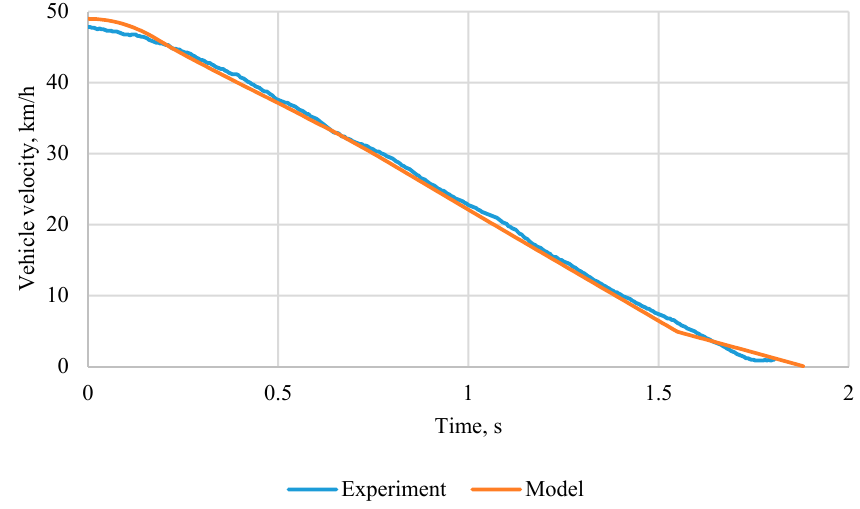
Figure 7. Validation of vehicle MM with anti-lock braking system (ABS).